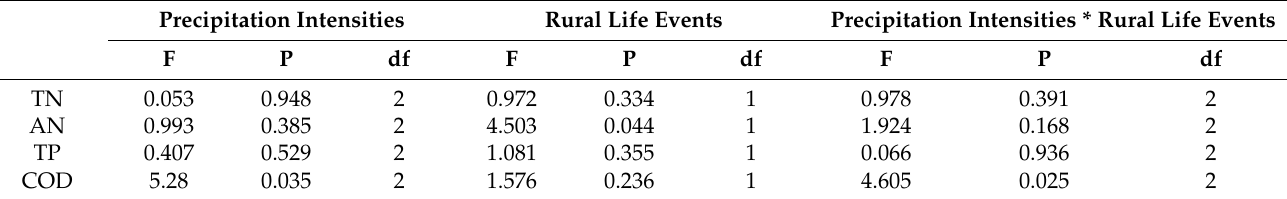
Figure 4. Removal capacity of the TIEPD under different precipitation intensities. The two-way ANOVAs suggested that the precipitation intensity and the interaction between the precipitation intensity and rural life events had significant influences on the COD removal efficiency ( p < 0.05) (Table 2). In addition, rural life events had a significant effect on the removal efficiency of AN ( p < 0.05). Beyond that, the precipitation intensity, rural life events and their interaction had no significant influences on the removal efficiencies of COD, AN, TN and TP ( p > 0.05). Table 2. Influence of pollutant load on removal efficiency of the TIEPD.